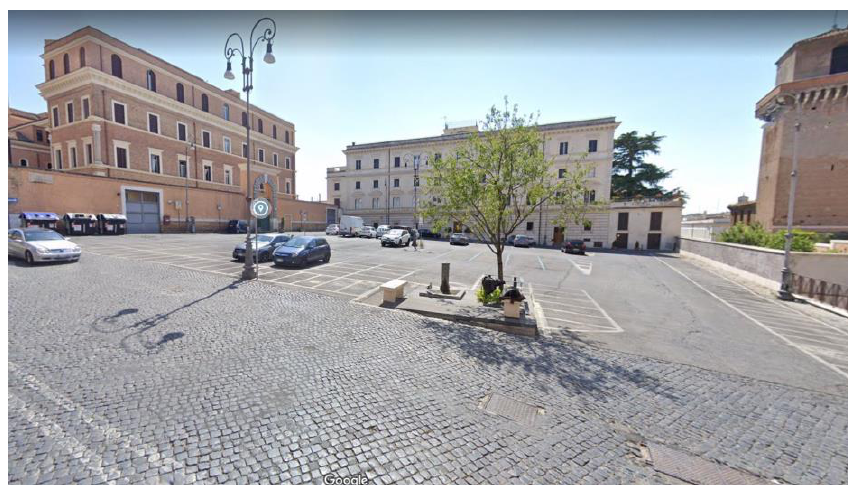
Figure 1. St Peter in Chains’ square, Rome, Italy (photo: Google maps).